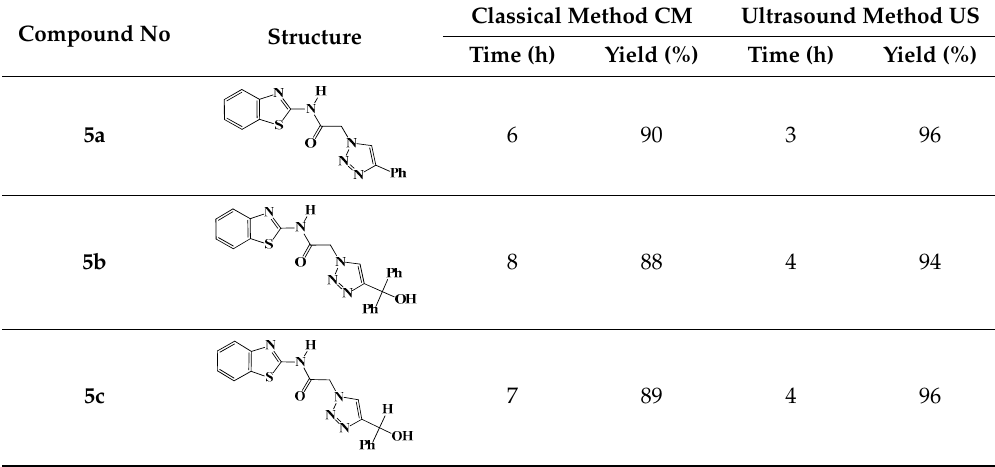
Table 2. Conventional versus ultrasound synthesis of 1,2,3-triazoles 5a – r .